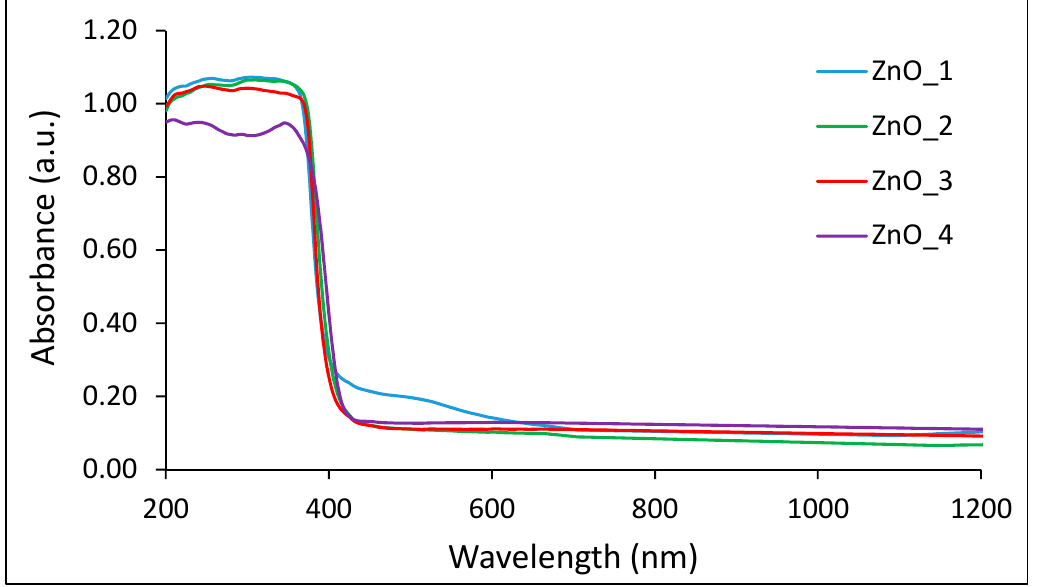
Figure 2. UV-vis spectra of ZnO nanopowders obtained in the microwave-assisted synthesis with various capping agents. ZnO_1 = sample synthesized in an alkaline medium without capping agent, ZnO_2 = synthesized in an alkaline medium in the presence of CTABr, ZnO_3 = synthesized in an alkaline medium in the presence of plant extract and ZnO_4 = synthesized only in the plant extract.